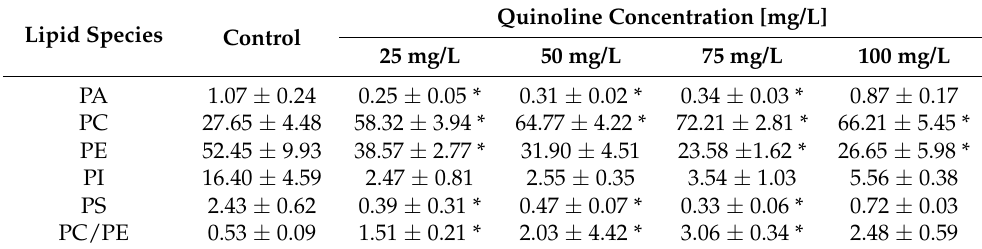
Table 2. The percentage of total phospholipids and their characteristic index values. Asterisk ( p < 0.05) indicates values that differ significantly from the